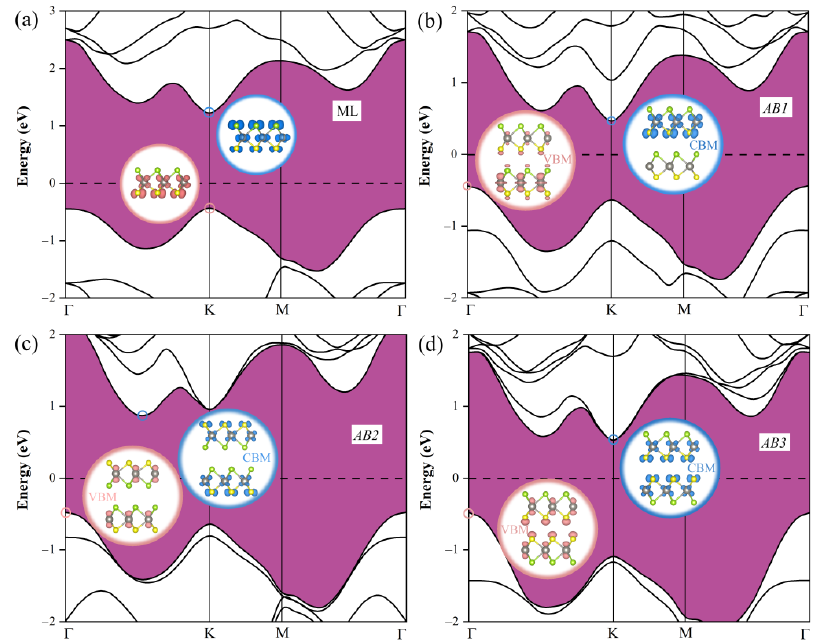
Figure 2. The electronic band structure of WSSe ( a ) monolayer (ML) and ( b ) AB1 , ( c ) AB2 , and ( d ) AB3 bilayers. The inserts show the spatial distributions of conduction band minimum (CBM) (blue areas) and valence band maximum (VBM) (pink areas), respectively. We set the isosurface value to 0.018 e/Å 3 .